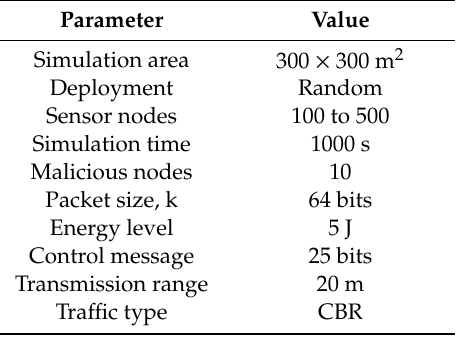
Table 2. Simulation